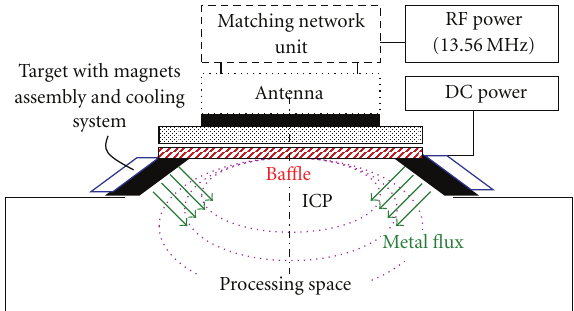
Figure 1: Cross-section of the IPVD system with annular conical target and high-density inductively coupled plasma (ICP)